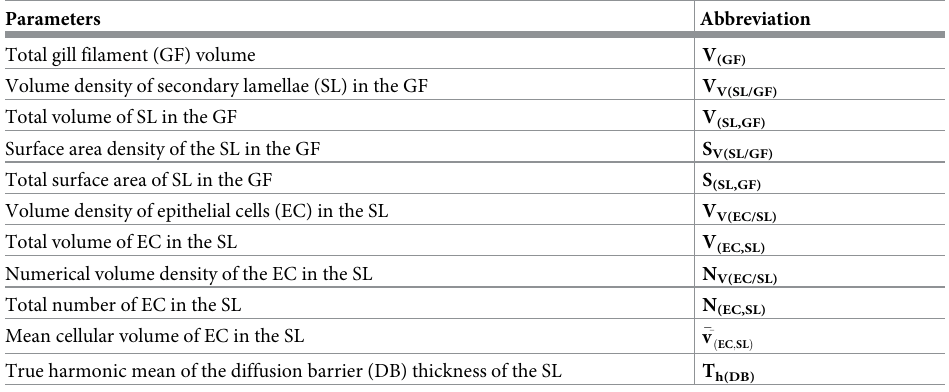
Table 2. Relevant quantitative stereological gill